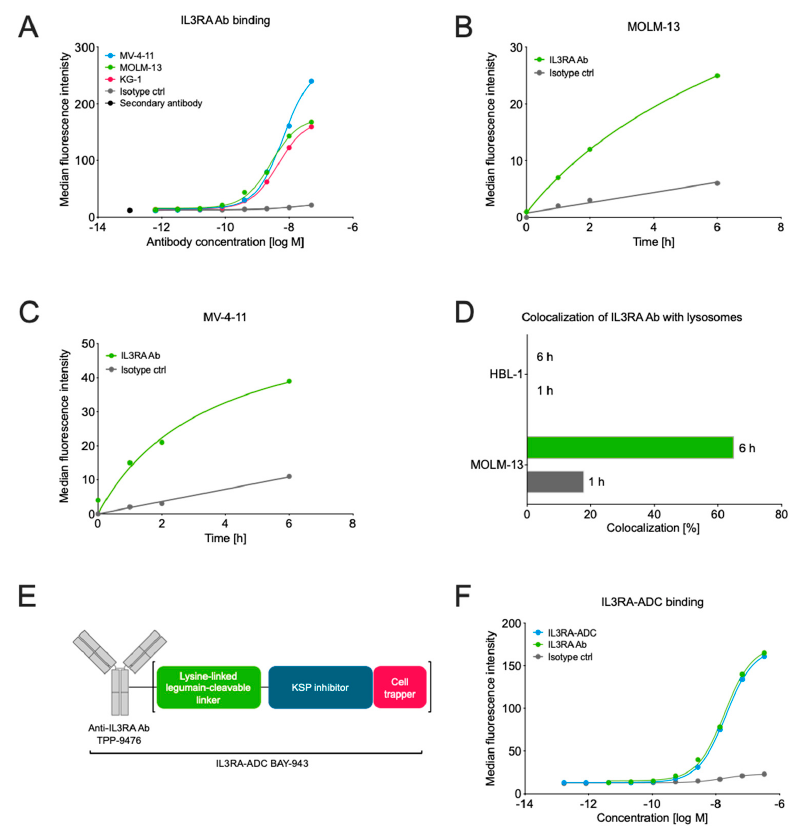
Figure 1. Characterization of the interleukin 3 receptor subunit alpha (IL3RA) antibody TPP-9476 and schematic representation of the IL3RA antibody–drug conjugate (ADC) BAY-943. ( A ) The binding of the IL3RA-targeting antibody (IL3RA Ab) TPP-9476 to IL3RA-positive hematologic cell lines as determined by flow cytometry. The obtained EC 50 values were 2.73 × 10 − 9 M for MOLM-13, 6.53 × 10 − 9 M for MV-4-11, and 4.54 × 10 − 9 M for KG-1 cells. ( B , C ) The internalization of the IL3RA Ab TPP-9476 and an isotype control antibody into IL3RA-positive MOLM-13 ( B ) and MV-4-11 ( C ) cells as determined by flow cytometry-based imaging. ( D ) The colocalization of the IL3RA Ab TPP-9476 in lysosomes in the IL3RA-positive MOLM-13 and IL3RA-negative HBL-1 cells. ( E ) Schematic representation of the IL3RA-ADC BAY-943. TPP-9476 represents the IL3RA-Ab. The “cell trapper” functionality indicates a non-cell-permeable payload metabolite that enables maximal retention in target cells after cleavage. ( F ) The binding of the IL3RA-ADC BAY-943 to IL3RA-positive MOLM-13 cells as determined by flow cytometry. The obtained EC 50 values were 20.4 × 10 − 9 M for ILRA3A-ADC and 18.7 × 10 − 9 M for ILRA3A Ab,